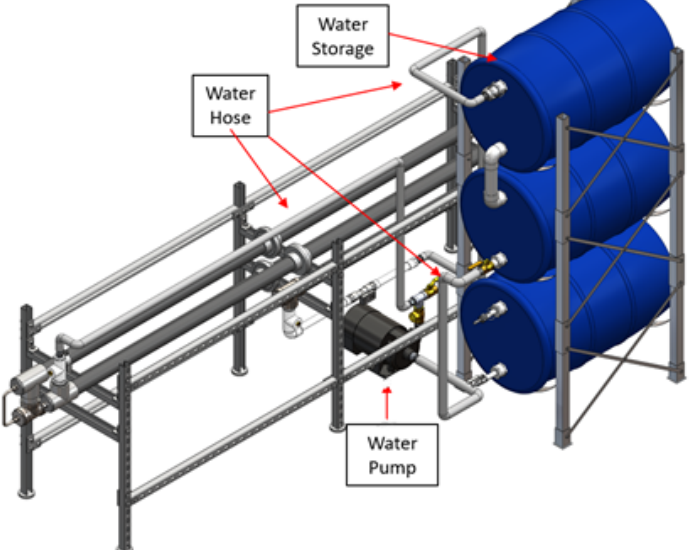
Figure 14. Heat exchanger with cooling loop.